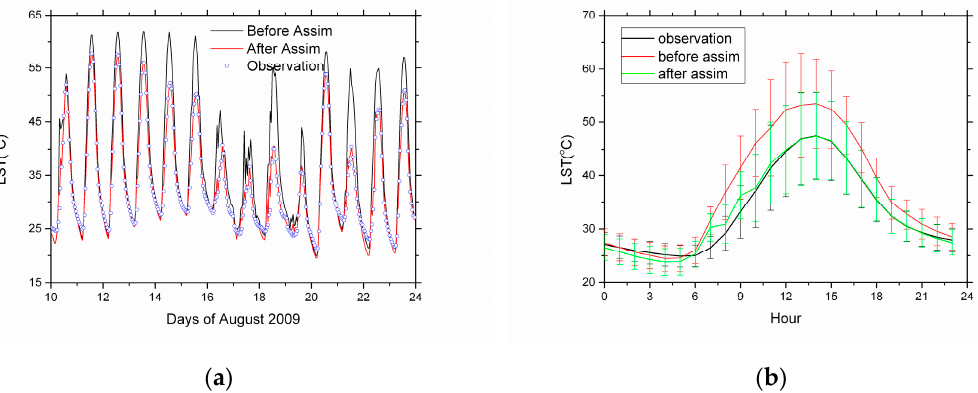
Figure 3. ( a ) Site average diurnal cycle of the sensible heat flux before and after assimilation; ( b ) comparison of the site average sensible heat flux differences with the LST differences from the control run and contrast run.